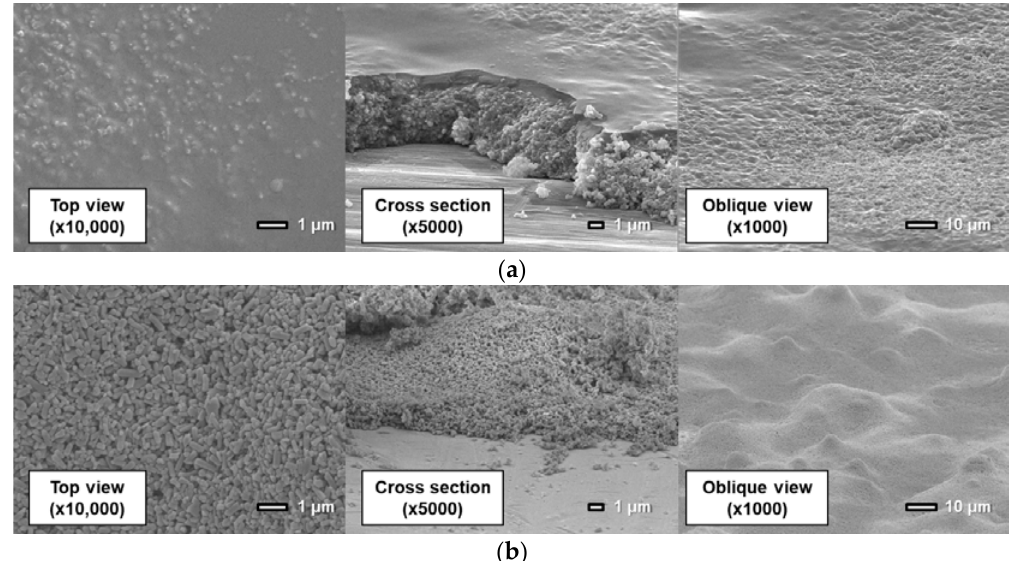
Figure 11. Scanning electron microscope images of the D-adsorbed PSP with a particle content of (a) 80 wt% and (b) 93 wt%.